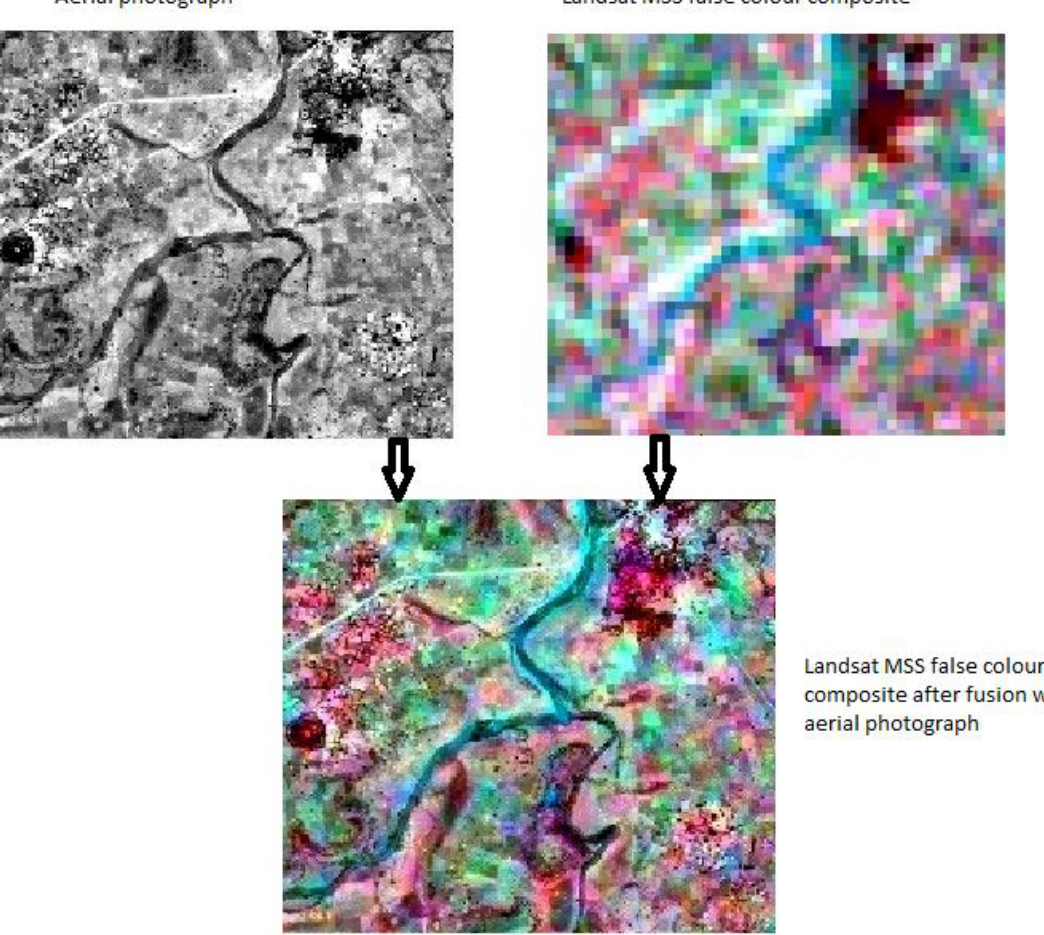
Figure 4. 1979 Landsat MSS false color composite of small part of the area around the .outlet of the Koga catchment before and after